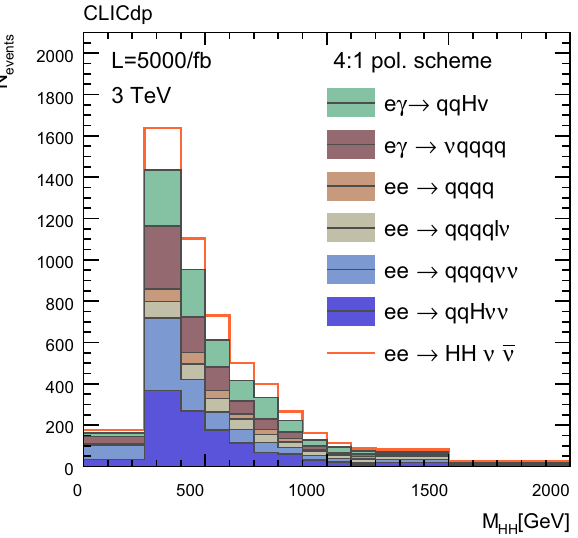
Fig. 6 Invariant mass of the Higgs boson pair for the SM contributions in the loose BDT selection at 3TeV